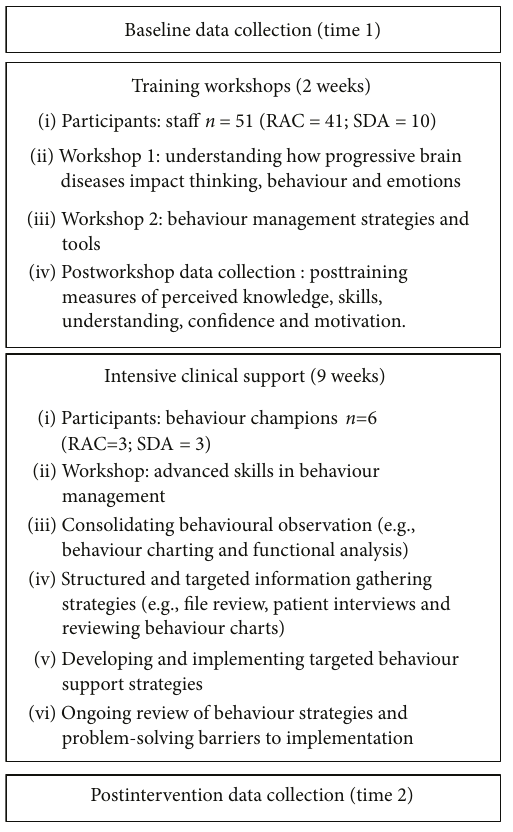
Figure 1: Timeline and